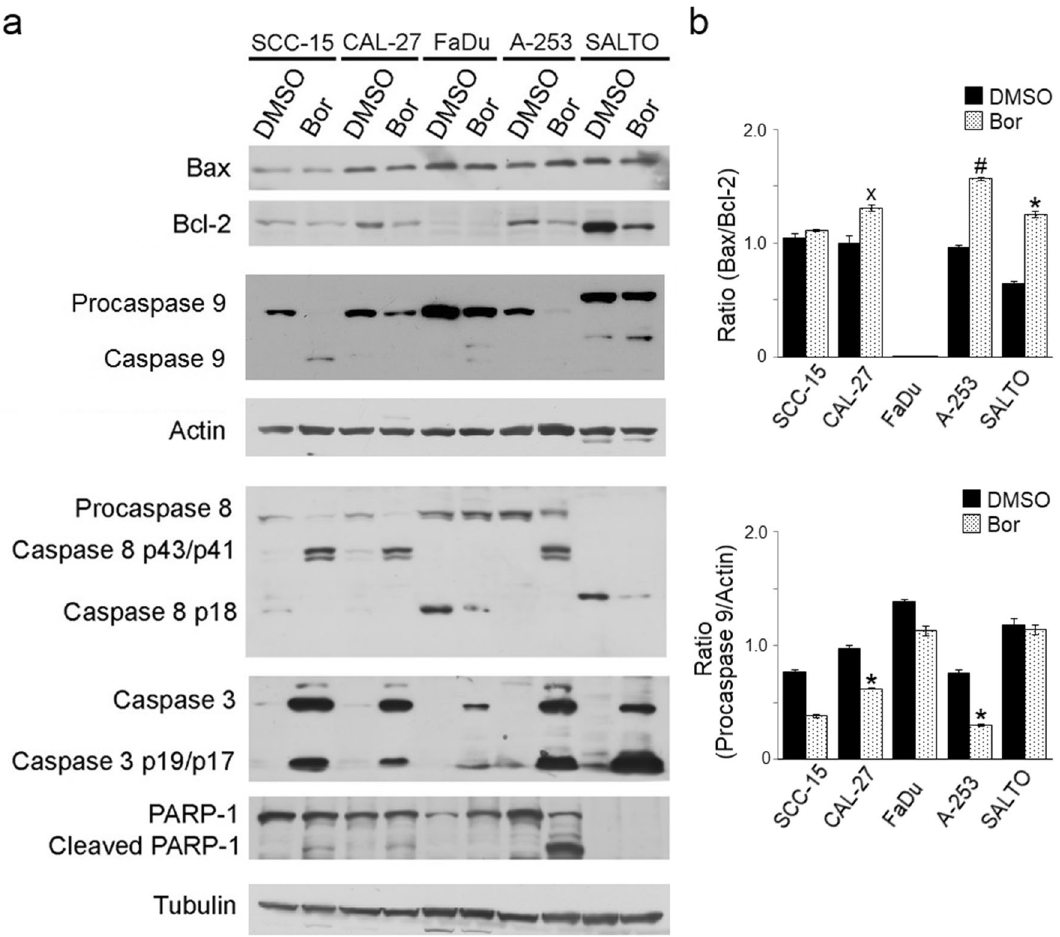
Figure 3. Effect of Bortezomib on the expression of molecules involved in apoptosis in tongue (SCC-15, CAL- 27), pharynx (FaDu), and salivary gland (A-253, SALTO-5) cancer cell lines. ( a ) The expression of Bax, Bcl-2, caspases 9, 8, 3, and PARP-1 was evaluated by Western blotting analysis following treatment for 24 or 48 h of HNC cells with Bortezomib (Bor) at a dose of 12.5 (SCC-15, CAL-27) or 25 nM or with DMSO, as reported in Materials and Methods. Actin and tubulin were used as an internal control. ( b ) The densitometric ratios between Bax and Bcl-2, between procaspase 9 and actin, and statistical analysis are reported ( ˟ p ≤ 0.05, * p ≤ 0.01, # p ≤ 0.001 vs DMSO). Data are expressed as the mean ± SD of two independent experiments. Uncropped western blots are reported in Supplementary